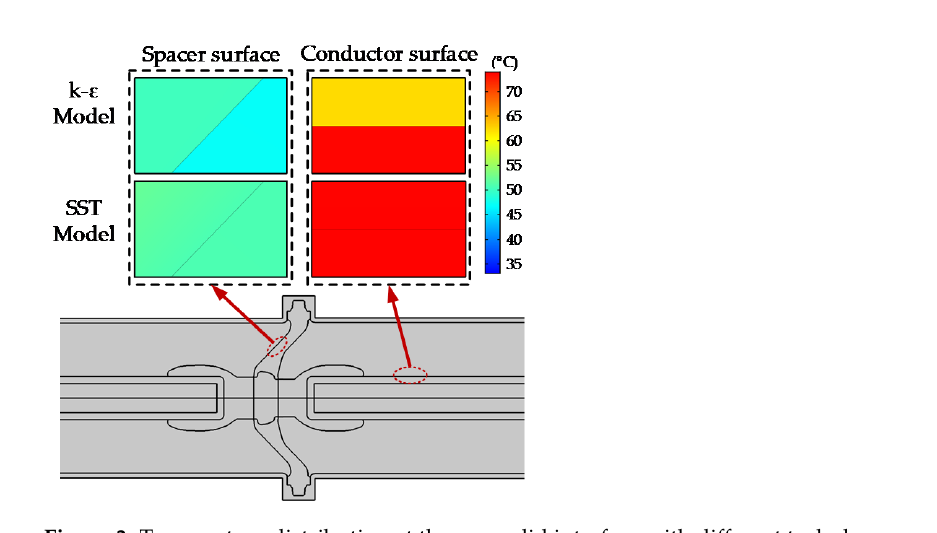
Figure 3. Temperature distribution at the gas–solid interface with different turbulence models.